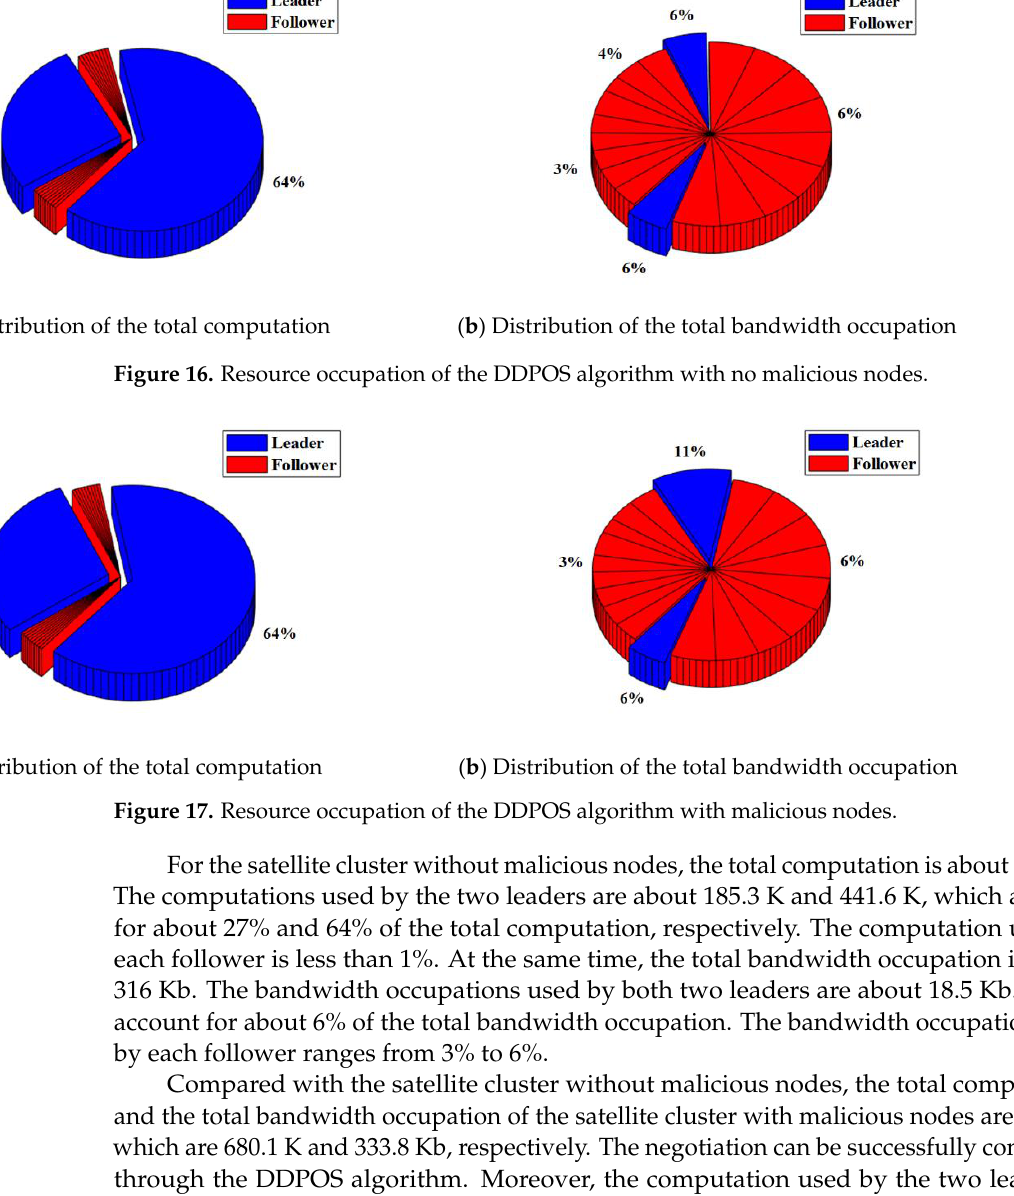
( b ) Distribution of the total bandwidth occupation Figure 15. Resource occupation of the DPOS algorithm with malicious nodes. 4.2.5. DDPOS In the DDPOS algorithm, satellites 1 – 10 are gathered to form the first leader group, and satellites 11 – 20 are gathered to form the second leader group. The satellite 1 and 11 are selected as the leaders and other satellites are followers. The PBFT algorithm is se- lected for the negotiation in the satellite cluster and the RAFT algorithm is used for the negotiation among satellite clusters. The results of the total computation and the total bandwidth occupation of the satellite cluster with or without malicious nodes are shown in Table 7. The distribution of the total computation and the total bandwidth occupation of the satellite cluster with or without malicious nodes are shown in Figures 16 and 17. Table 7. The performance of the DDPOS algorithm. Total Computation (freq) Total Bandwidth Occupation (Kb) No malicious nodes 686.4 K 316.0 Malicious nodes contained 680.1 K 333.8 For the satellite cluster without malicious nodes, the total computation is about 686.4